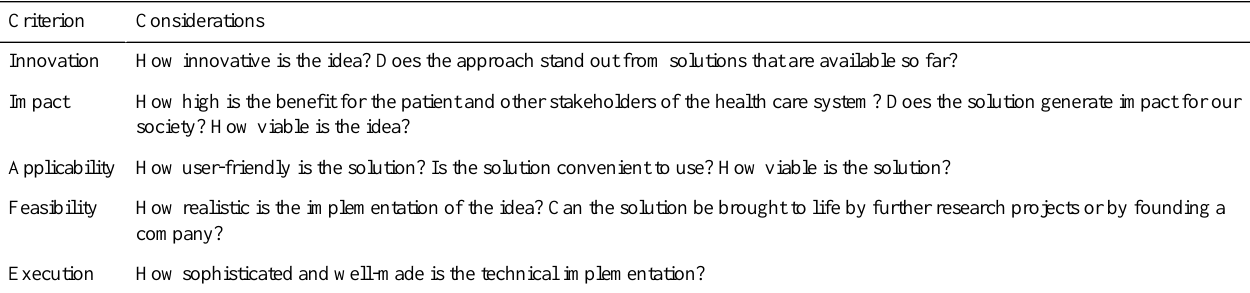
Table 2. Evaluation criteria for the projects presented in the final pitch session at the end of the hackathon.